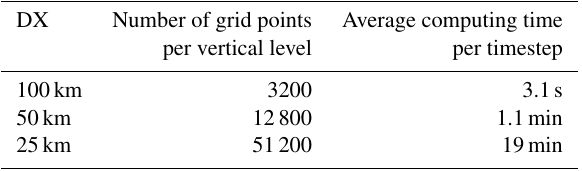
Table 2. The dependence of computing time on model resolution. Note that the numbers of grid points are per vertical level, whereas the computing times are per the whole 3-D domain. DX Number of grid points Average computing time per vertical level per timestep 100km 3200 3.1s 50km 12800 1.1min 25km 51200